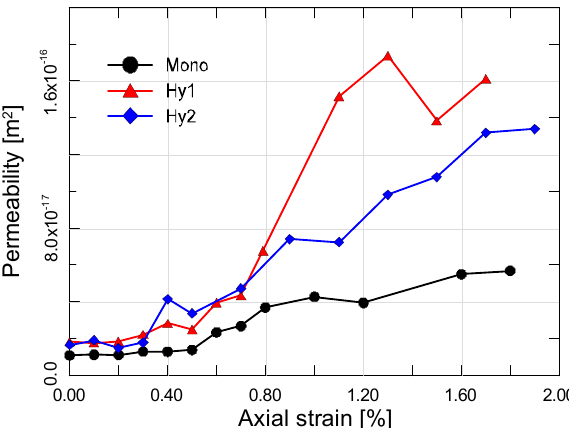
Figure 10. Comparison of typical permeability evolution curves of ECC mixtures with different steel fiber content.